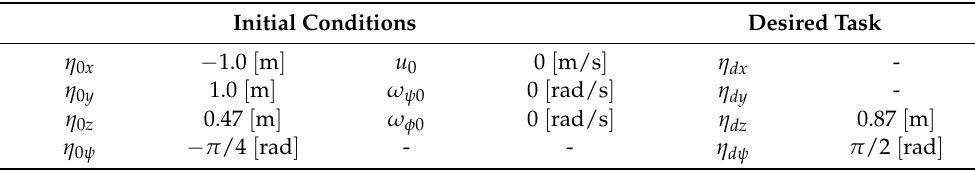
Table 5. Desired task and initial